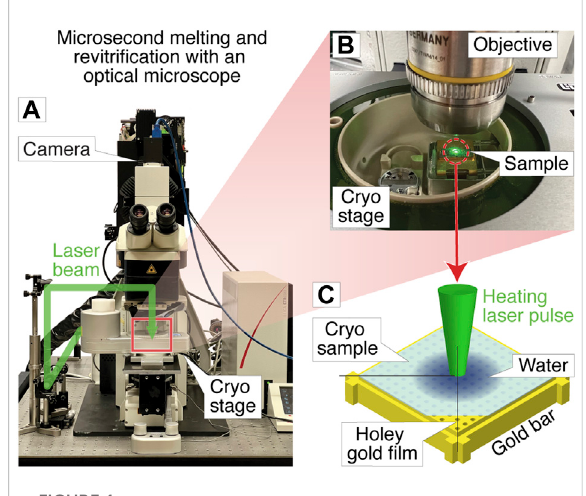
FIGURE 1 Melting and revitri fi cation of cryo samples with an